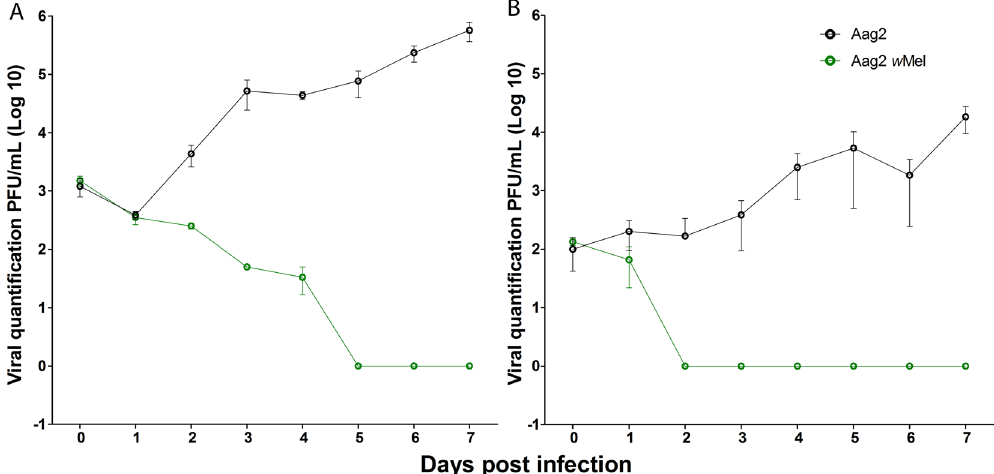
Figure 2. Kinetics of MAYV viral growth and the Wolbachia blocking effect. ( A , B ) Aag2 cells were challenged with two different MOIs: ( A ) MOI 0.1 and ( B ) MOI 0.01. Aag2 without Wolbachia (black line) maintained steady growth for both MOIs. The Aag2- w Mel cell line (green line) had significant effect on MAYV growth. MOI of 0.1 exhibited a later blocking effect. Viral titration of MAYV-containing supernatant was determined by plaque assay for 3 days after infection in Vero cells. Cells were infected in triplicate, and the values represent means ±